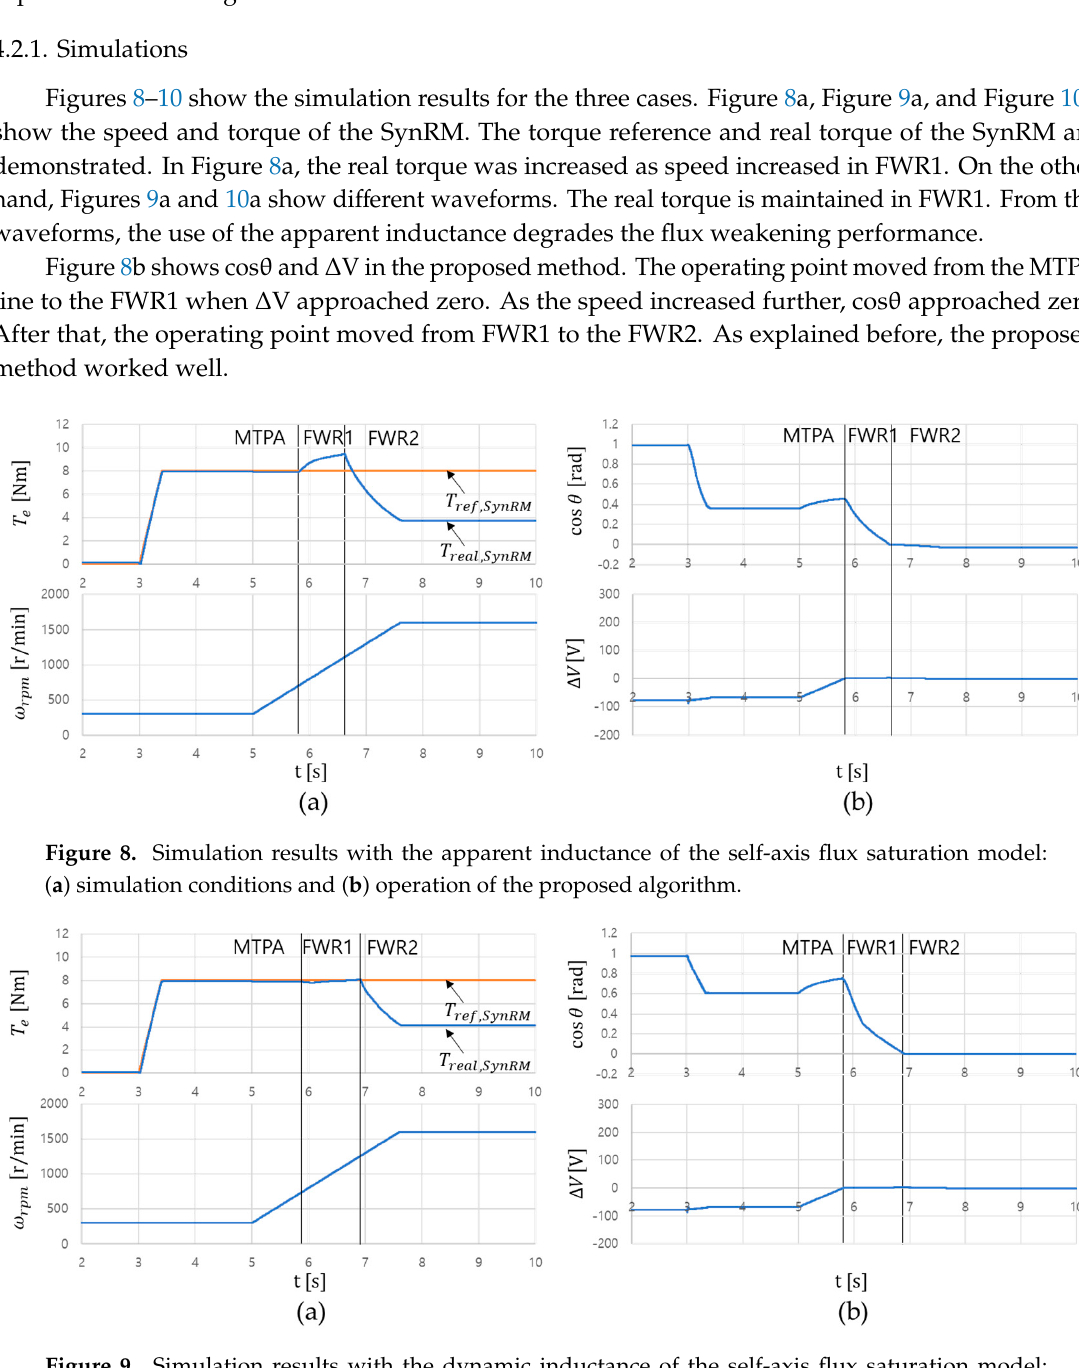
Figure 9. Simulation results with the dynamic inductance of the self-axis flux saturation model: ( a ) simulation conditions and ( b ) operation of the proposed algorithm.